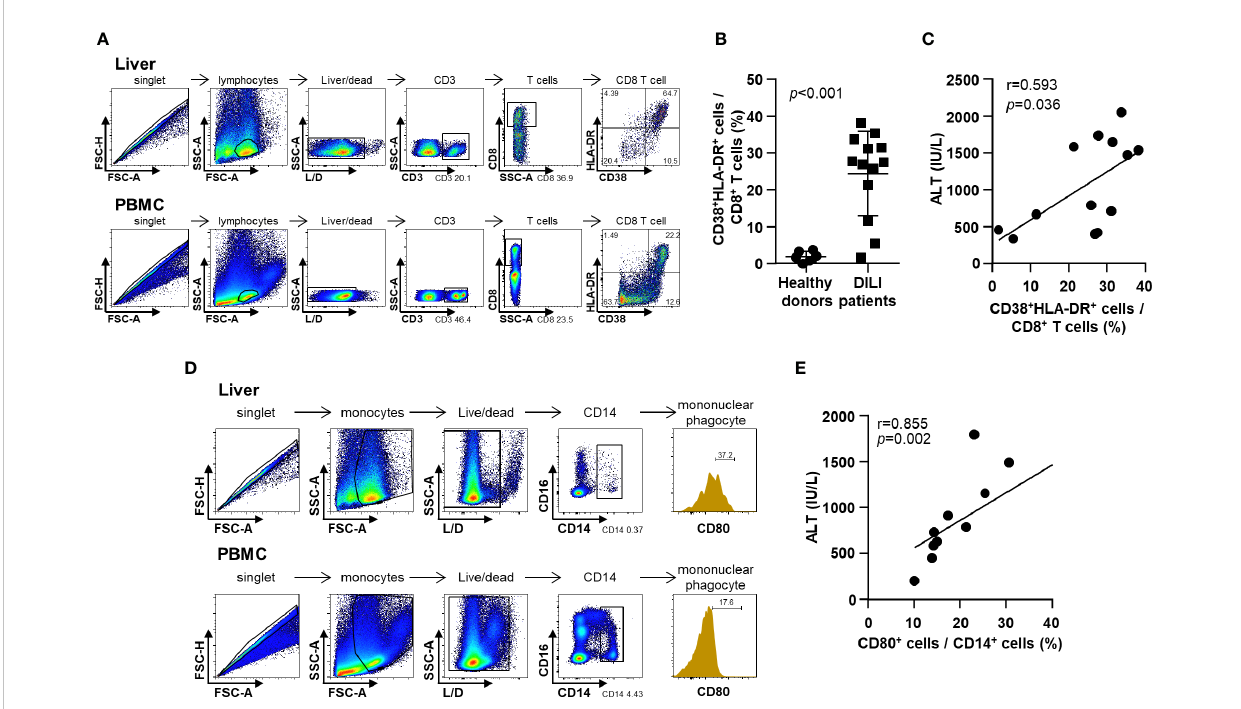
FIGURE 3 Phenotypes of in fi ltrative immune cells in the DILI livers. (A) Representative fl ow cytometry result of intrahepatic T cell activation in a patient with DILI. (B) Frequency of activated (CD38 + HLA-DR + ) CD8 + T cells in patients with DILI was signi fi cantly higher than that in healthy donors (p < 0.001). (C) Percentage of activated (CD38 + HLA-DR + ) CD8 + T cells in DILI livers was positively correlated with serum ALT (r = 0.593, p = 0.036). (D) Representative fl ow cytometry result of intrahepatic mononuclear phagocyte activation in a patient with DILI. (E) Percentage of activated (CD80 + ) CD14 + mononuclear phagocytes in the DILI livers was positively correlated with serum ALT (r = 0.855, p = 0.002). Correlations between variables were analyzed using Spearman or Pearson coef fi cients. PBMC, peripheral blood mononuclear cell; ALT, alanine